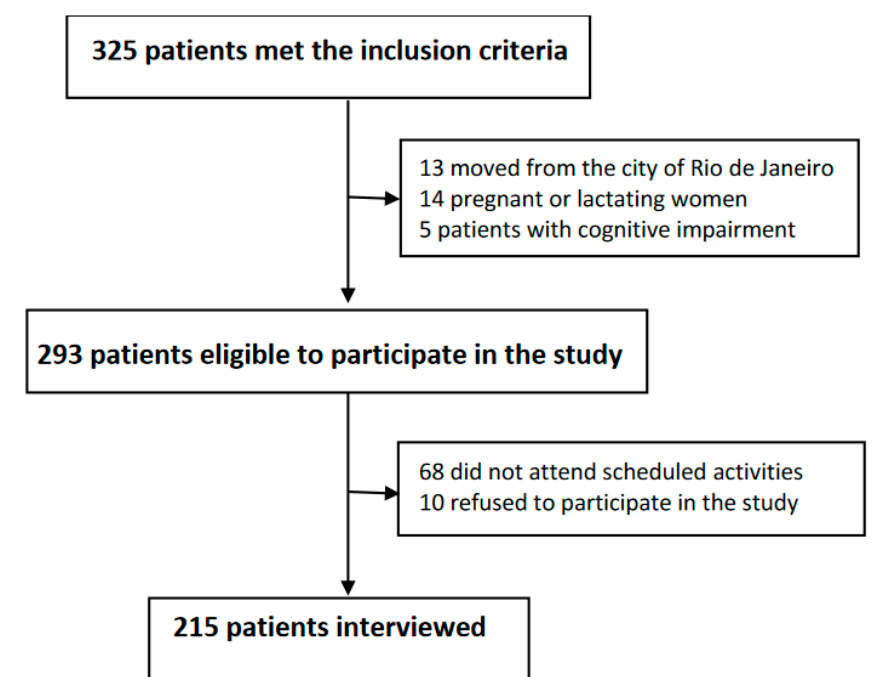
Figure 1. Study Figure 1. Study fl owchart .